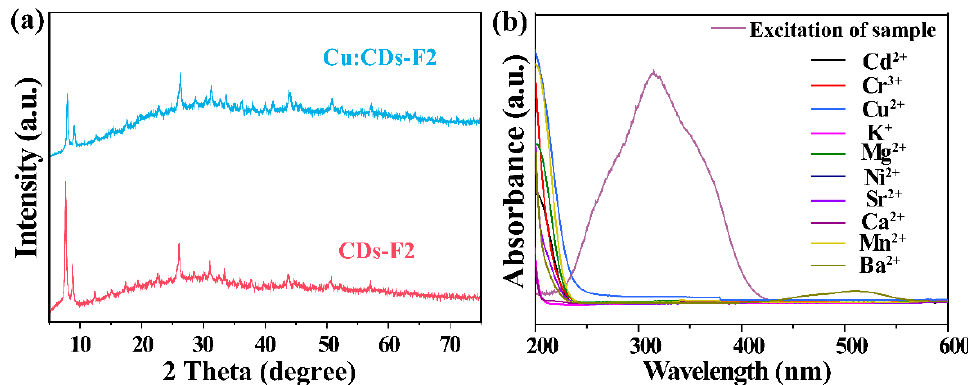
Figure 5. ( a ) PXRD patterns of CDs-F2 before and after sensing the solution of Cu 2+ . ( b ) UV spectra of heavy metals and excitation spectrum of CDs-F2.